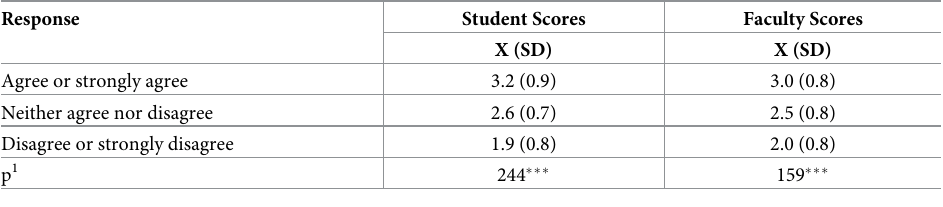
Table 8. ARAS-composite PD score versus responses to survey question AAS-6b, “I do not think that there is any- thing wrong with using animals in medical